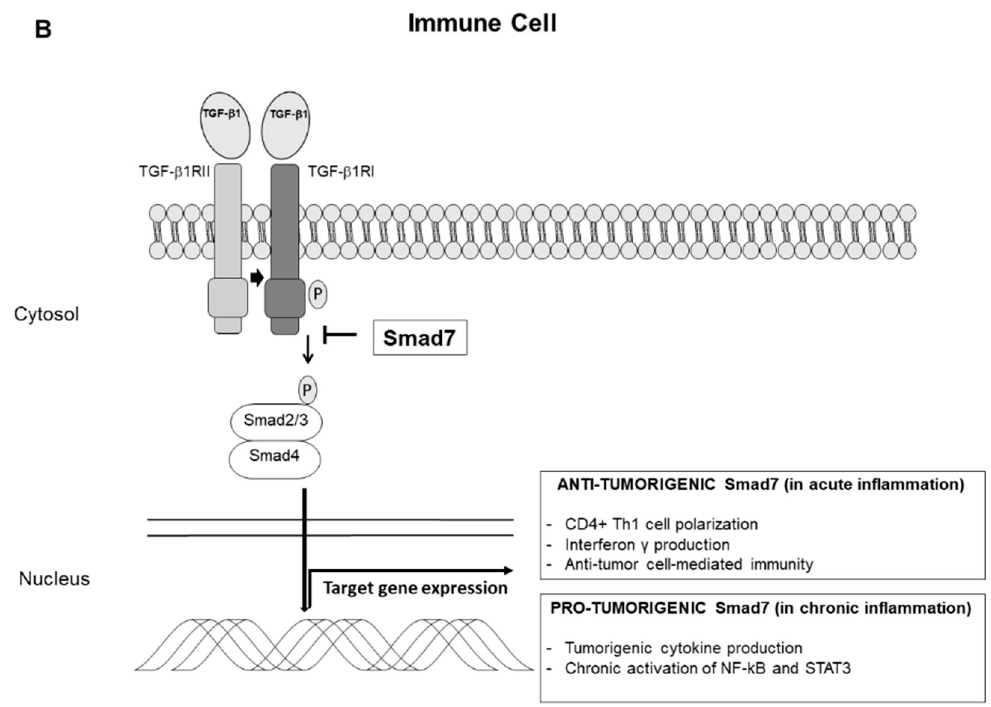
Figure 1. Graphic representation of the Transforming Growth Factor (TGF)- β 1 / Smad7 signaling and the contrasting e ff ects in epithelial cells ( A ) and immune cells ( B ) on carcinogenesis. Smad7 binds to TGF- β receptor type I and prevents TGF- β 1-driven Smad2 / 3 phosphorylation (P), impairing the transcription of the TGF- β 1 target genes and opposing the pro-tumorigenic or anti-tumorigenic e ff ects of TGF- β 1, depending on the stage of carcinogenesis. High Smad7 prevents also eukaryotic translation initiation factor-2 α (eIF2 α ) phosphorylation, either directly or through the inhibition of protein kinase RNA (PKR), thus leading to downregulation of transcription factor 4 (ATF4) and CCAAT / enhancer binding protein homology protein (CHOP) with the down-stream e ff ect of stimulating cell cycle progression and cancer cell growth in a TGF- β 1-independent manner.